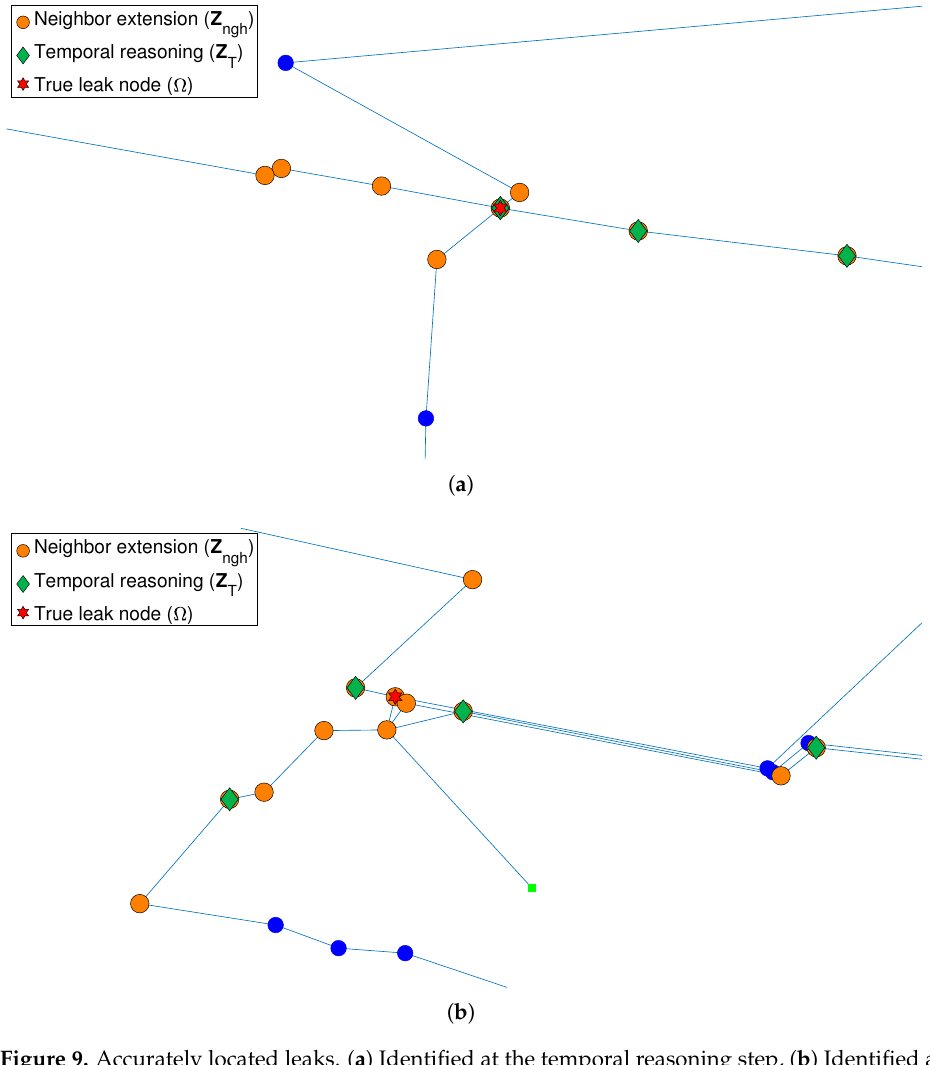
Figure 9. Accurately located leaks. ( a ) Identified at the temporal reasoning step, ( b ) Identified at the neighbor expansion